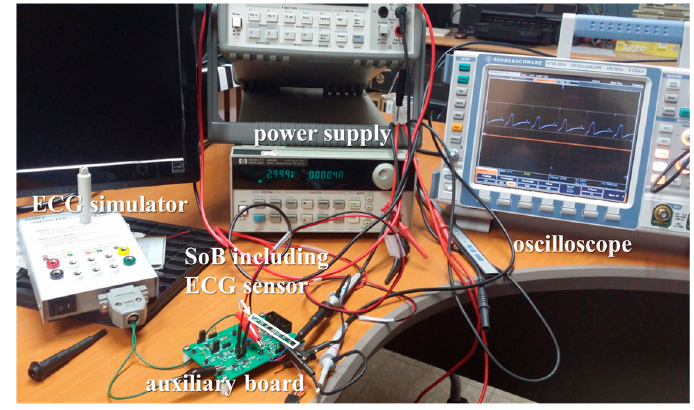
Figure 10. Power consumption test of the ECG sensor.